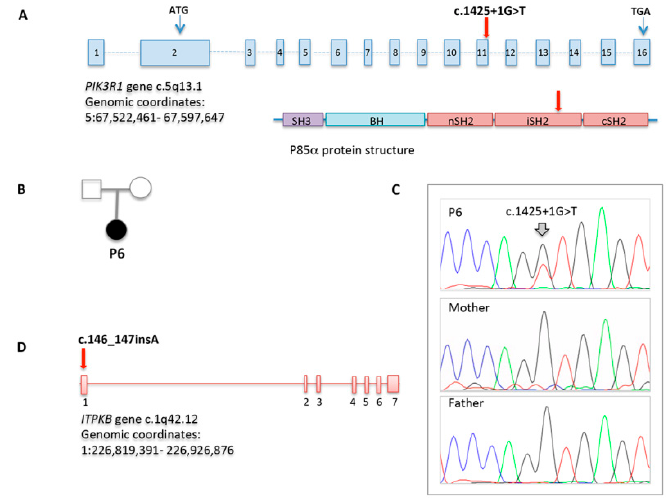
Figure 5. PIK3R1 and ITPKB variations identified through WES. ( A ) PIK3R1 gene structure which encodes p85 α protein. The splice site mutation in patient P6 is indicated; ( B ) Pedigree of the family carrying the PIK3R1 mutation; ( C ) Sequencing chromatograms in patient P6 and her parents; ( D ) ITPKB gene structure with the frameshift mutation identified in patient P4. Chromosome location and genomic coordinates are provided.